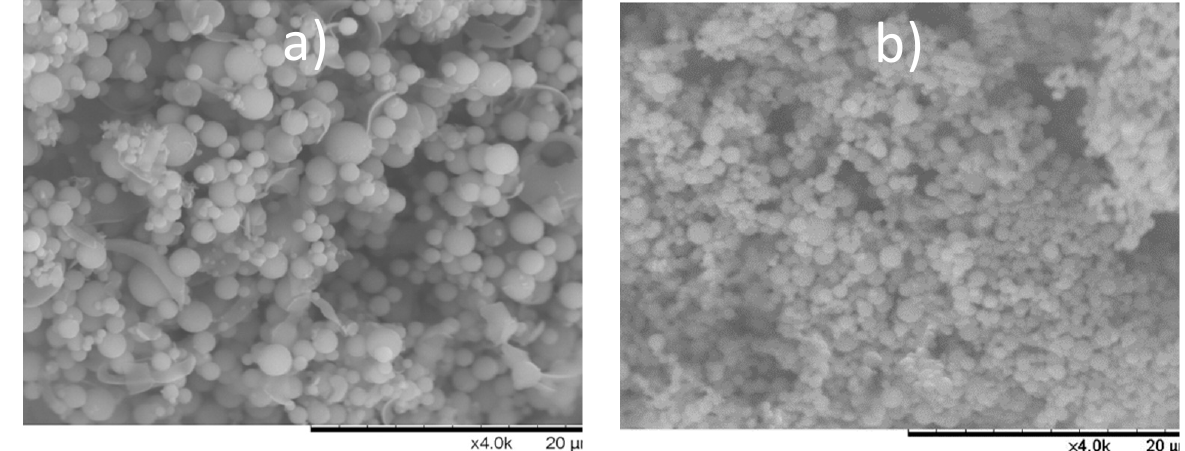
Figure 2. SEM of ( a ) CAR:ASP ×4000 and ( b ) CAR:TRP ×4000.